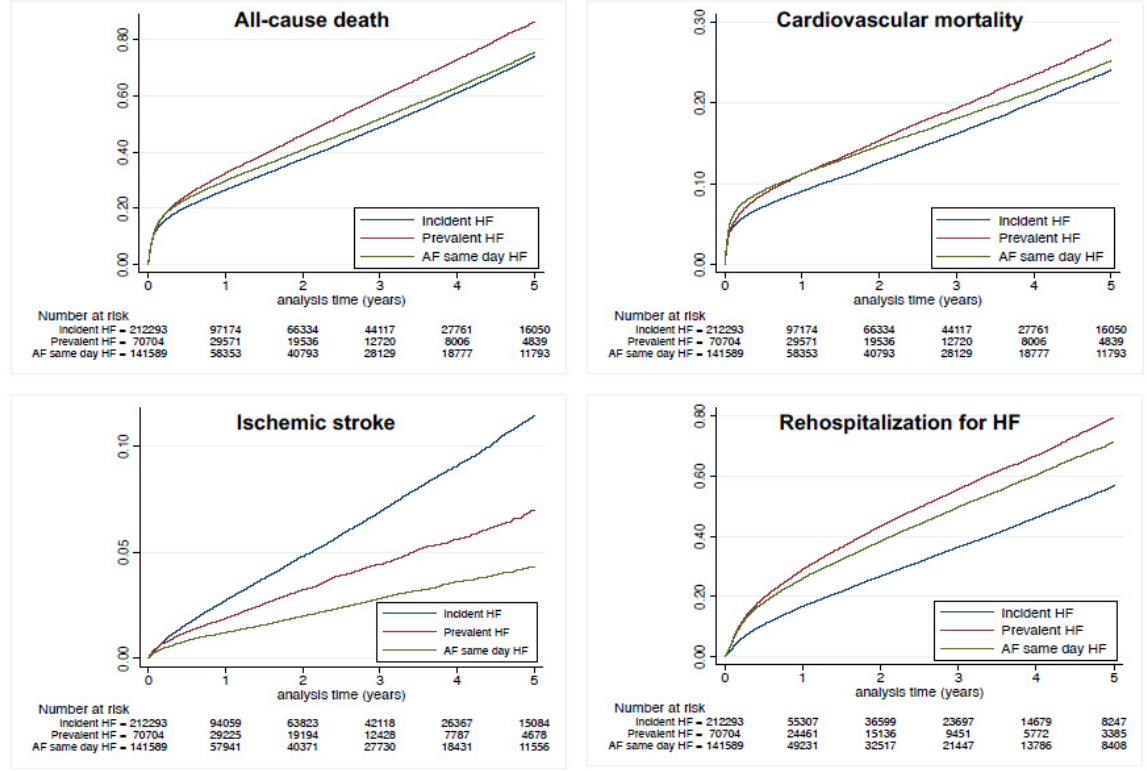
Figure 5. Cumulative incidences for all-cause death ( top left panel ), cardiovascular death ( top right panel ), ischemic stroke ( lower left panel ) and re-hospitalization for HF ( lower right panel ) in the matched cohorts of patients with (1) incident HF, (2) prevalent HF or (3) AF and HF diagnosed during the same hospitalization (follow-up starting at the time of AF). Compared to prevalent HF (i.e., HF earlier than AF) as the reference, hazard ratio was 0.90 (0.88–0.91) for AF and HF diagnosed during the same hospitalization and 0.85 (0.84–0.86) for incident HF when analyzing the risk of all-cause death; 0.98 (0.95–1.00) and 0.86 (0.84–0.88), respectively, when analyzing the risk of cardiovascular death; 0.64 (0.60–0.69) and 2.44 (2.32–2.57), respectively, when analyzing the risk of ischemic stroke; and 0.92 (0.90–0.93) and 2.26 (2.22–2.29) respectively when analyzing the risk of re-hospitalization for HF.